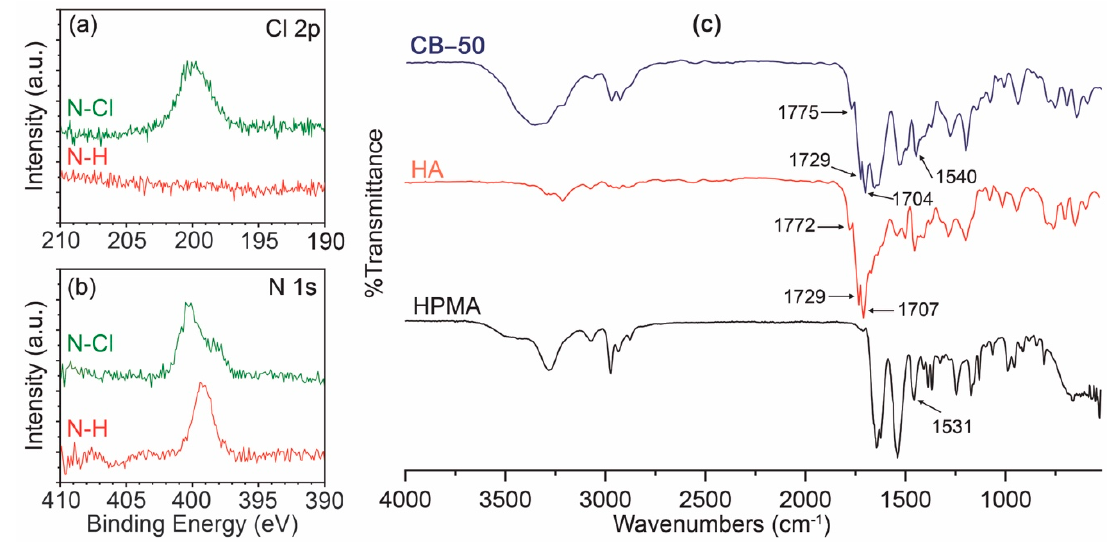
Figure 1. High-resolution XPS spectra of Cl 2p ( a ) and N 1s ( b ) spectra of CB-50 . FTIR spectra of N -(2-hydroxypropyl)methacrylamide) (HPMA), hydantoin acrylamide (HA), and CB-50 ( c ). The surface morphology of brush-gels was determined using AFM, as depicted in Figure 2. It was determined that the film morphologies appeared as needle-like structure heterogeneously distributed over the entire substrate area, where the root-mean-square (RMS) roughness of CB-0 , CB-25 , CB-50 , and CB-75 brush gels was 8.310, 7.870, 11.647, and 11.785 nm, respectively. The increase in RMS roughness values of the polymer brushes was possibly due to the increasing steric hindrance with the HA ratio.